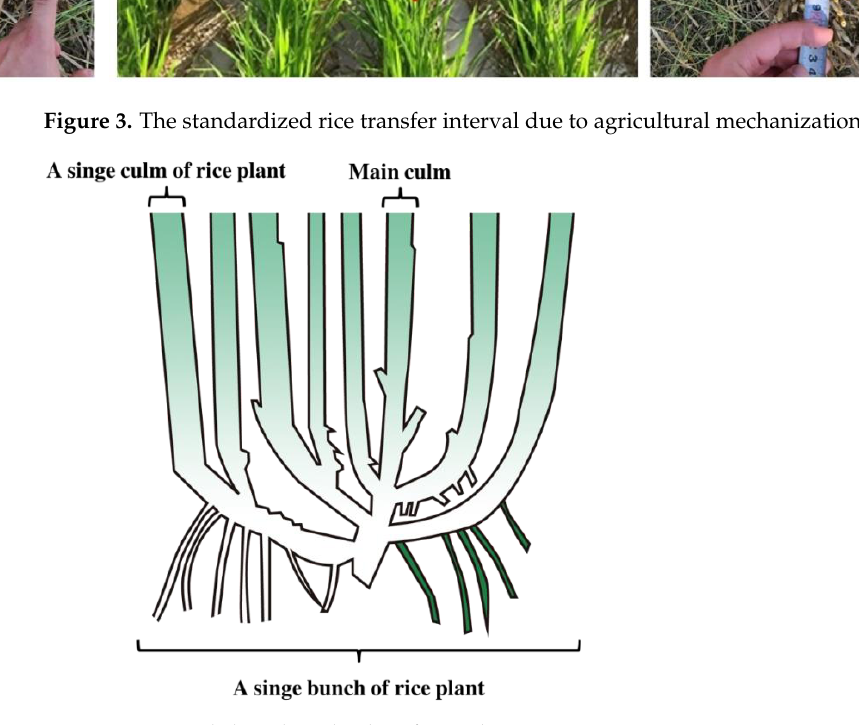
Figure 4. Example bunch and culm of rice plant.